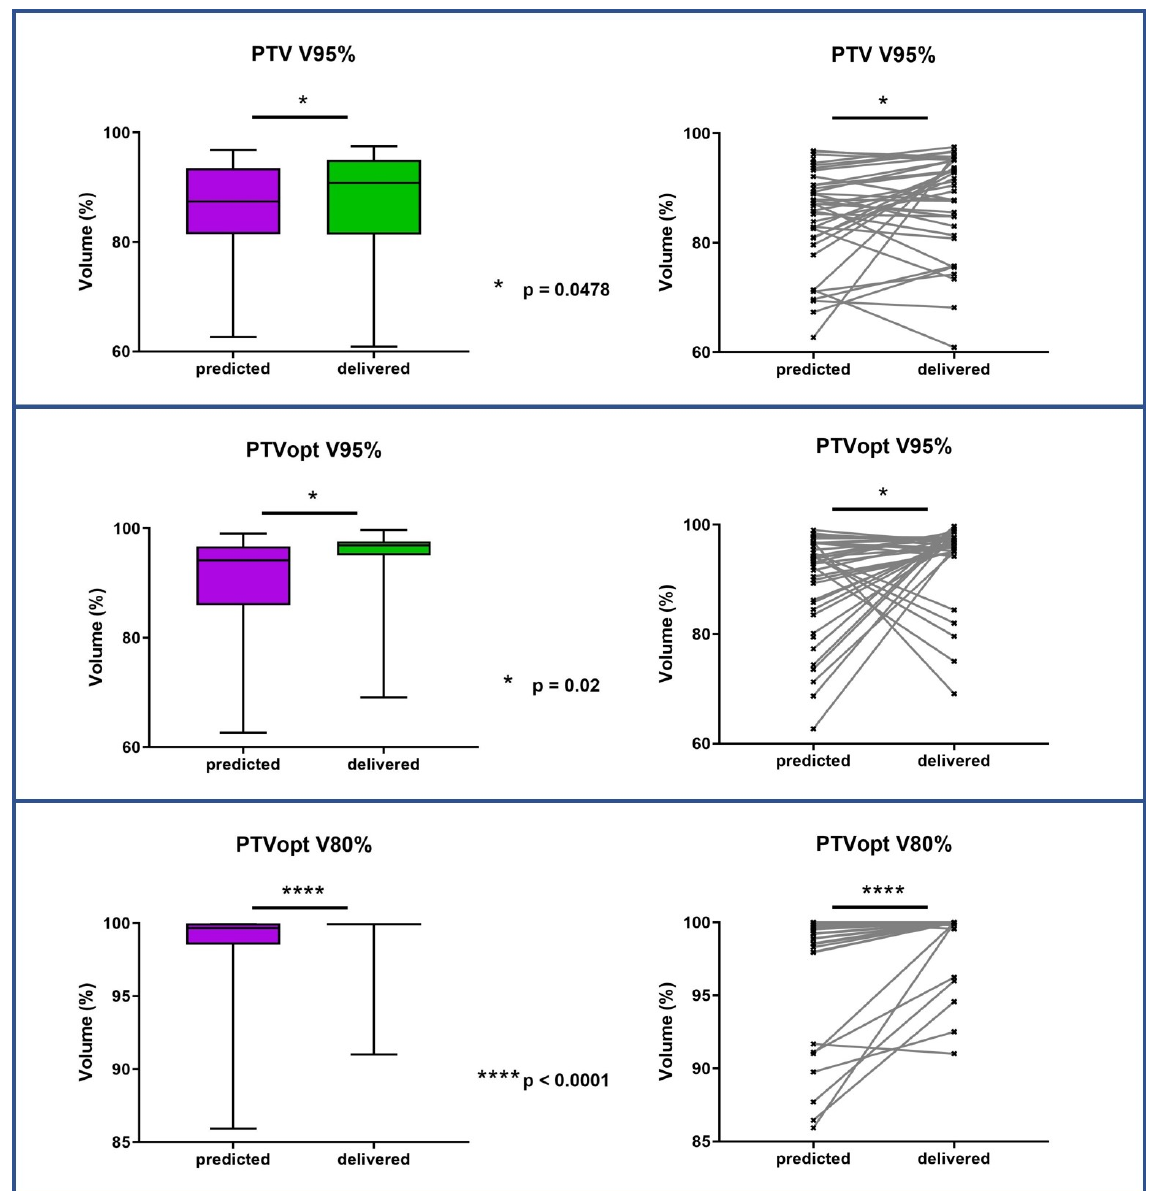
Figure 2. PTV and PTVopt coverage variations between predicted fractions (baseline plan on daily anatomy) and delivered fractions (new plan on daily anatomy). PTV = planning target volume; PTVopt = PTV optimized.